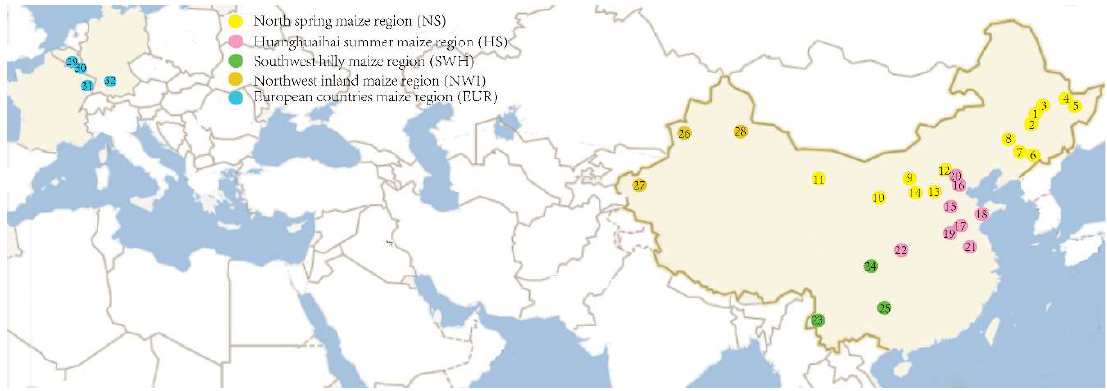
Figure 1. Sampling locations of R. padi in China and Europe. Numbers on the map correspond to